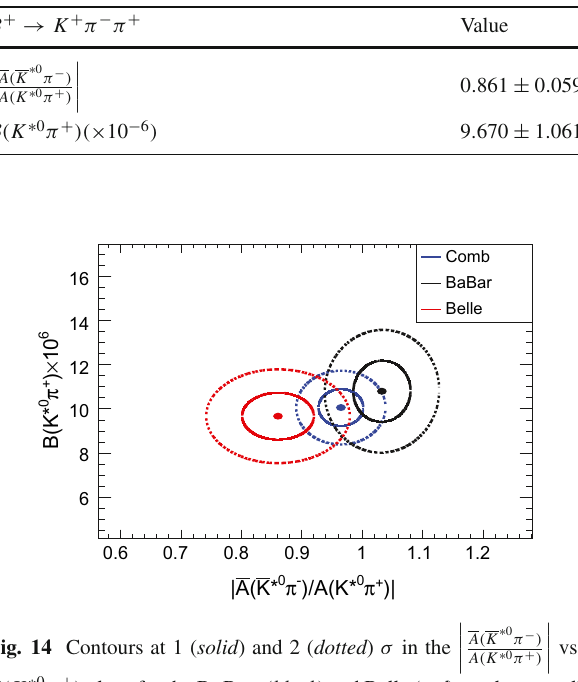
Fig. 14 Contours at 1 ( solid ) and 2 ( dotted ) σ in the B ( K ∗ 0 π + ) plane for the BaBar ( black ) and Belle ( red ) results, as well as the combination ( blue